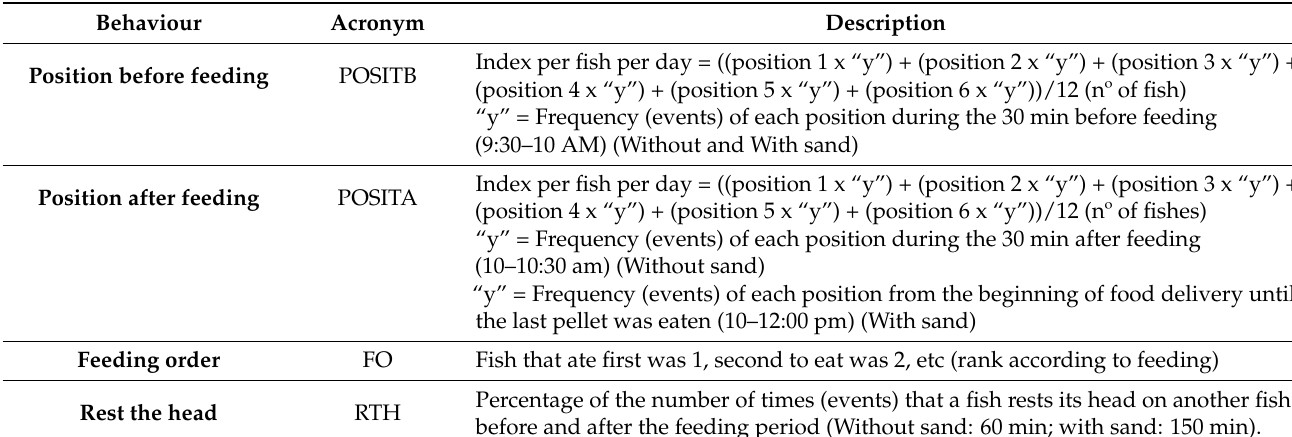
Table 1. Behavioural parameters registered during the dominance test performed in Senegalese sole. Behaviour, acronym and description of each behaviour are